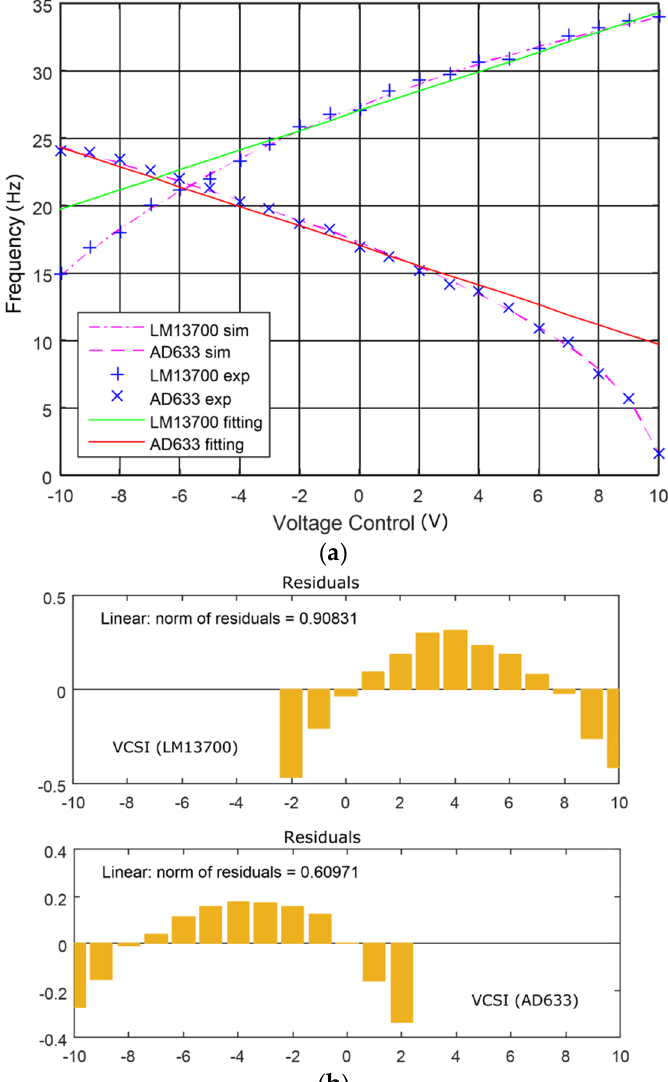
Figure 6. Voltage-controlled synthetic inductor: ( a ) simulation, experimental results, and linear fitting; and ( b ) comparative residuals analysis for equal voltage control ranges.